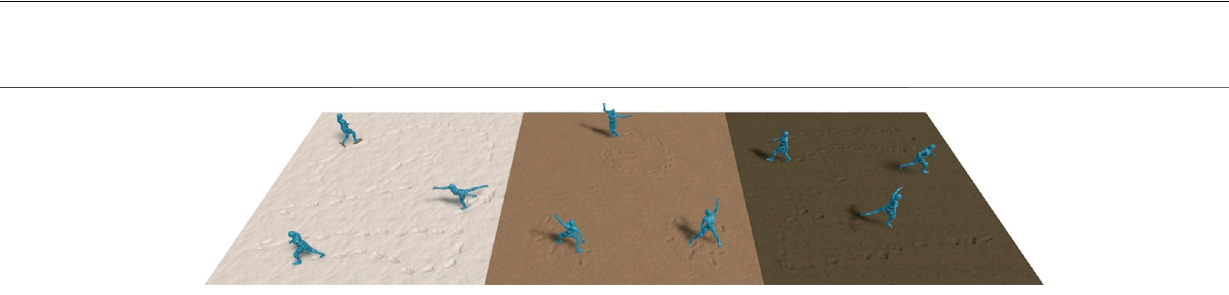
FIGURE 9 | Dynamic adaptation of the character ’ s walking gait to the change of the terrain. Red: default character walking on fl at ground. Blue: our result, with a character, locally adapting its posture to the evolving terrain.